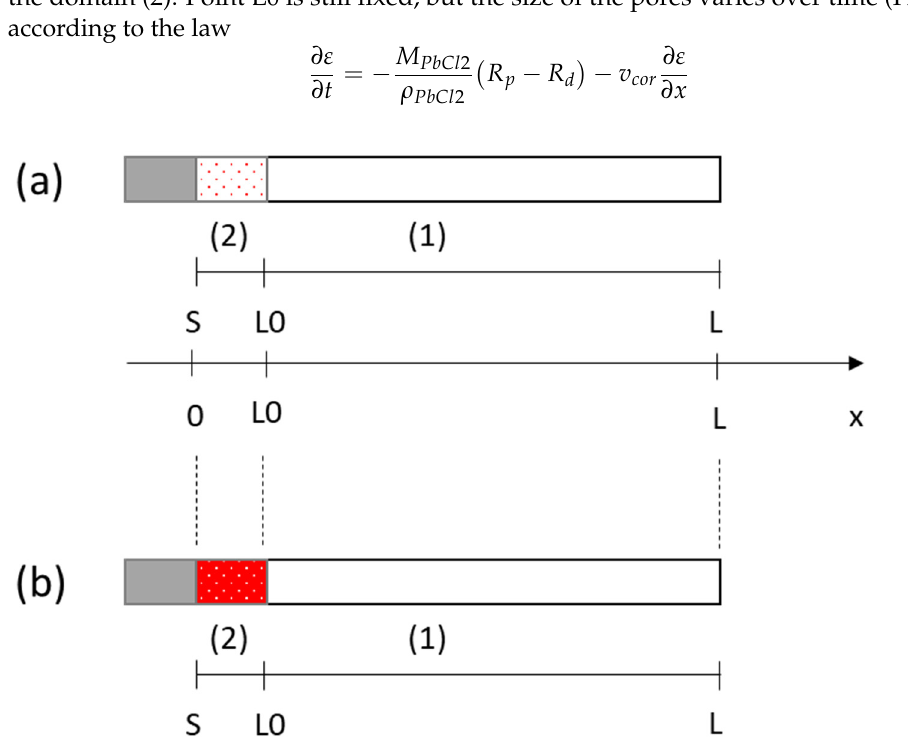
Figure 4. Schematic representation of the evolution of the CPL by variation of the porosity over time. The points S, L0 and L are fixed. ( a ) ε at t0 and ( b ) ε at t.